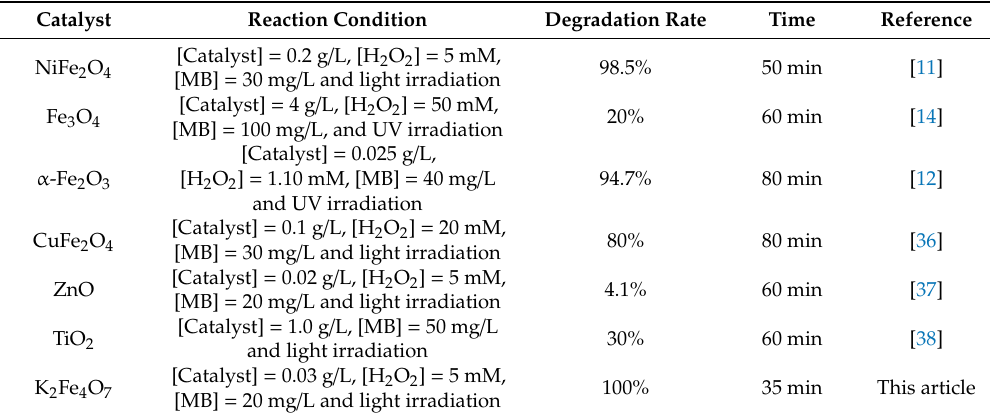
Table 1. Comparison of various catalytic systems for methylene blue (MB) degradation under di ff erent photo-Fenton